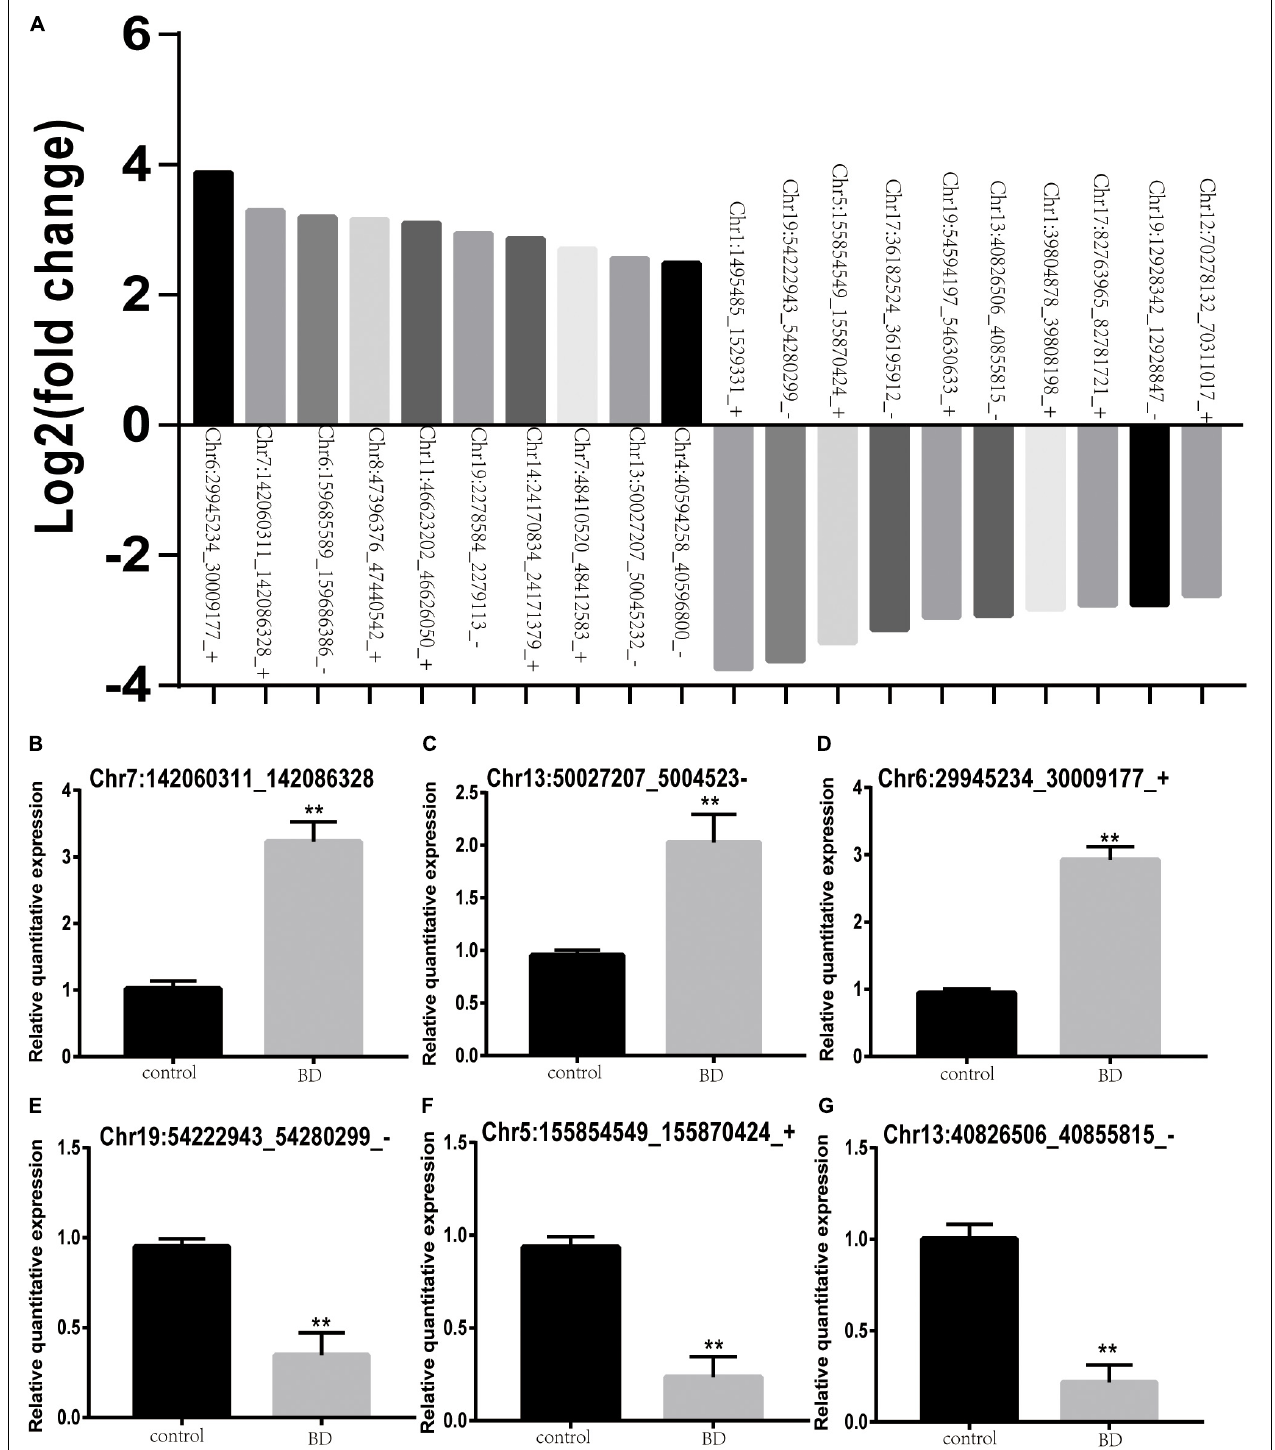
FIGURE 3 | Validation of the expression levels of DE-circRNAs in BD patients and control subjects. (A) Top 10 upregulated and downregulated DE-circRNAs between two groups. (B–G) Chr7:142060311_142086328 (B) , Chr13:50027207_50045232_– (C) , and Chr6:29945234_30009177_+ (D) were the three upregulated circRNAs. Chr19:54222943_54280299_– (E) , Chr5:155854549_155870424_+ (F) and Chr13:40826506_40855815_– (G) were downregulated circRNAs. Black stars indicate significant differences.